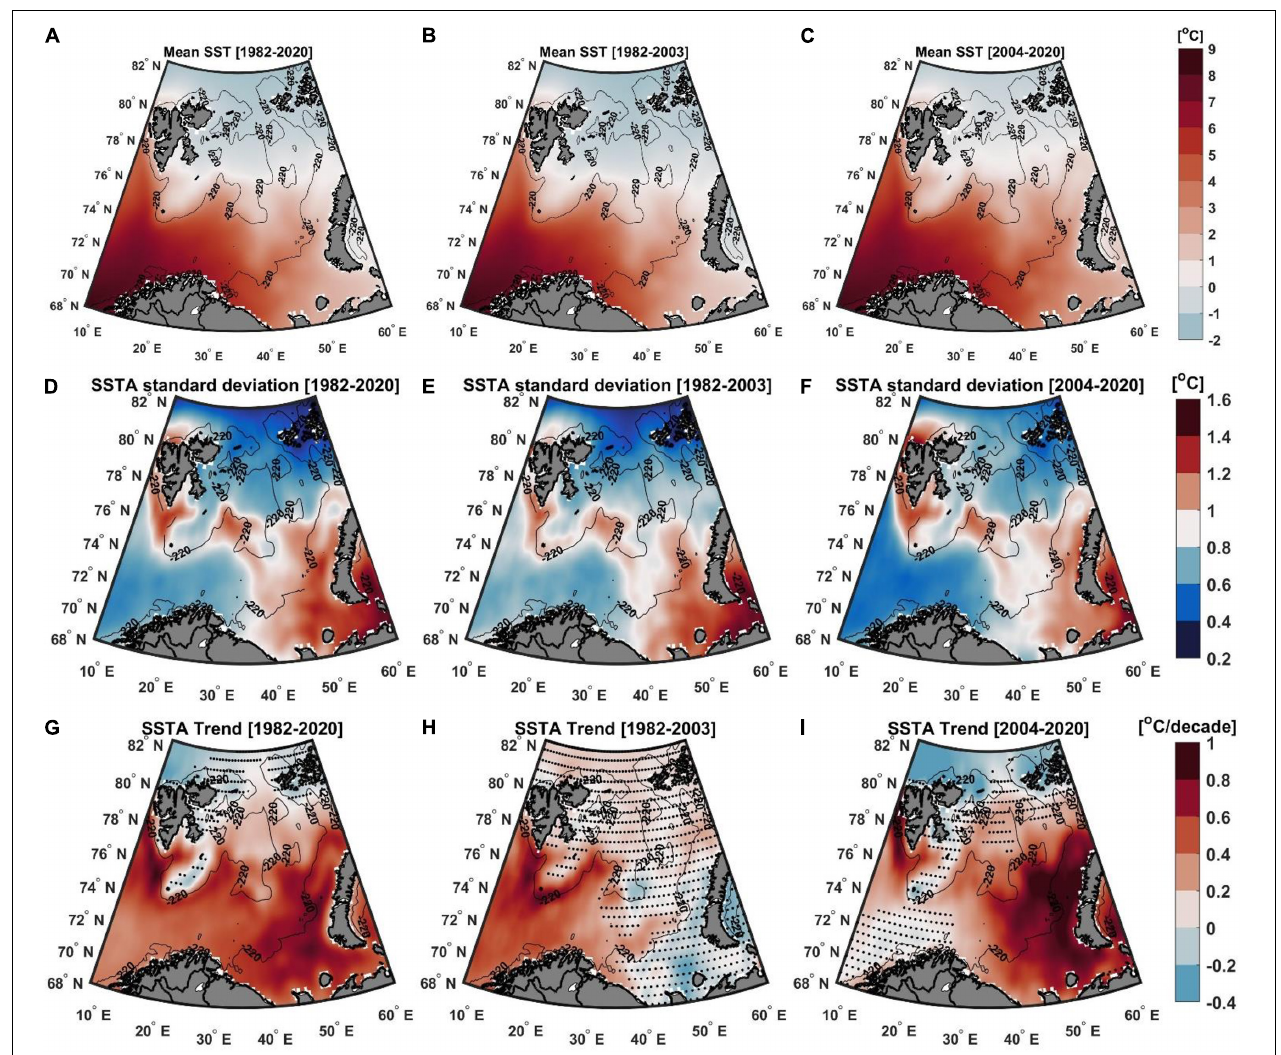
FIGURE 3 | Spatial distribution of climatological mean SST (top panel row), standard deviation of the detrended SSTA (middle panel row), and SSTA trends (bottom panel row) for the periods: 1982–2020 (A,D,G) , 1982–2003 (B,E,H) , and 2004–2020 (C,F,I) . Stippled regions indicate trends that are not statistically significant at the 95% confidence level. The black contour line represents the isobath of 220